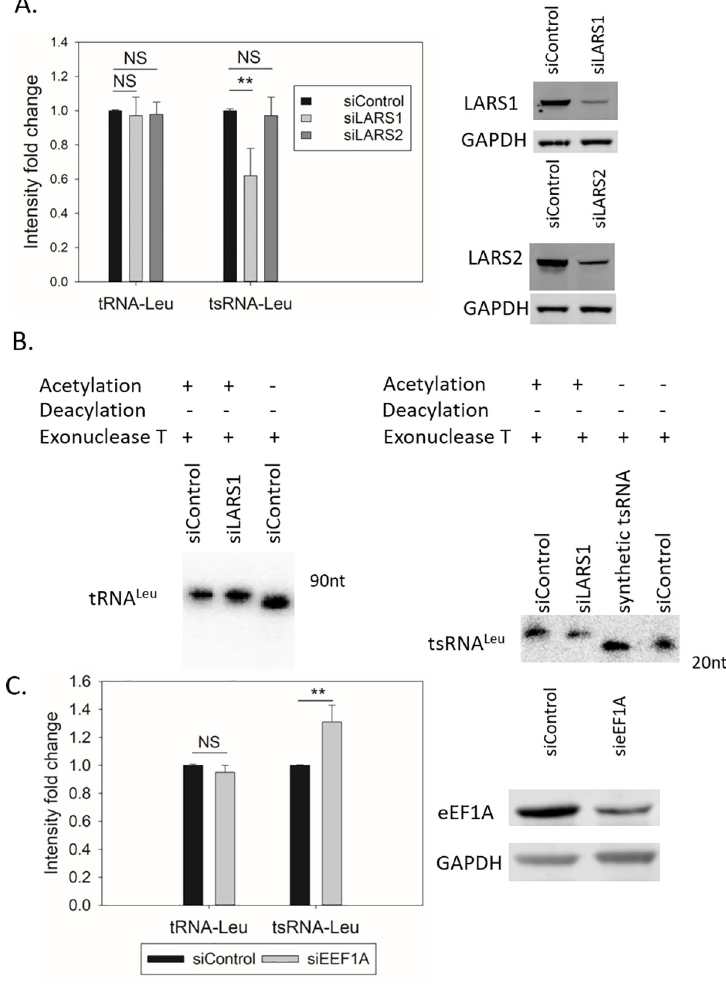
Fig 3. Knockdown of LARS1 decreases tsRNA Leu . (A) siRNAs targeting either LARS1 or LARS2 were transfected into HeLa cells in a 6-well plate. Total RNA was extracted after 72 hours, and northern blots were performed to quantify the tRNA Leu and tsRNA Leu levels. Values are presented as means ± s.d. (n = 9). �� , P < 0.01, NS, not significant, as determined by Student’s one-tailed t-test. Western blots were used to estimate the concentration of LARS1 and LARS2 protein. (B) tRNA Leu and tsRNA Leu are both fully charged in cells transfected either with LARS1 siRNA (siLARS1) or negative control siRNA (siControl). A chemically synthetic 22-mer tsRNA oligo was treated and used as a size control. (C) siRNA control or targeting eEF1A were transfected to HeLa cells and total RNA was extracted 72 hours later. Northern blots were performed to quantify the tRNA Leu and tsRNA Leu levels. Values are presented as means ± s.d. (n = 3). �� , P < 0.01, NS, not significant. Western blots were performed to quantify eEF1A protein